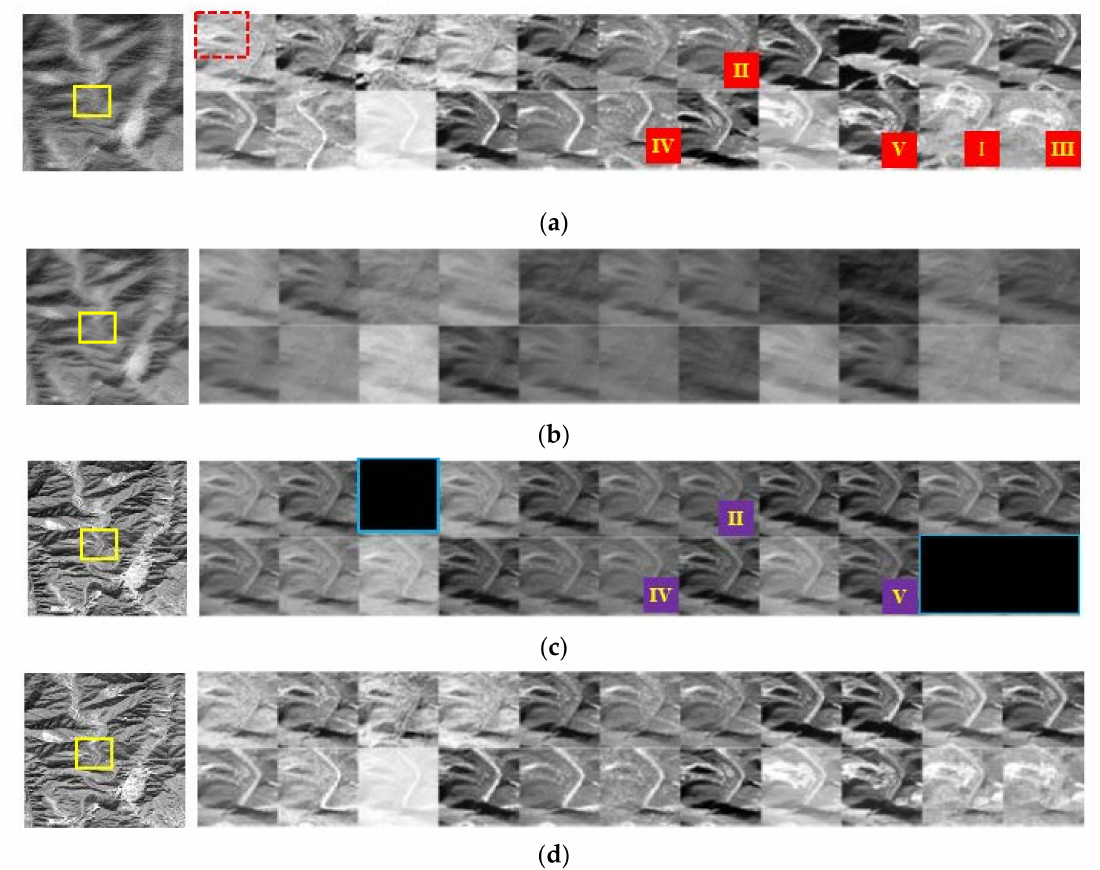
Figure 12. Global mean image (3900 × 4000 pixels) and local areas (780 × 800 pixels) of the remote sensing image sequence and relevant results by LRC-BRE and CCFR in the mine environmental treatment area. The leftmost images of ( a – d ) are the global mean images of the original image sequence, the stable feature image sequence restored by LRC-BRE, the stable feature image sequence restored by CCFR, and the image sequence registered by CCFR, respectively. The right images of ( a – d ) are the local areas of the above image sequence, whose spatial position corresponds to the yellow box of the left